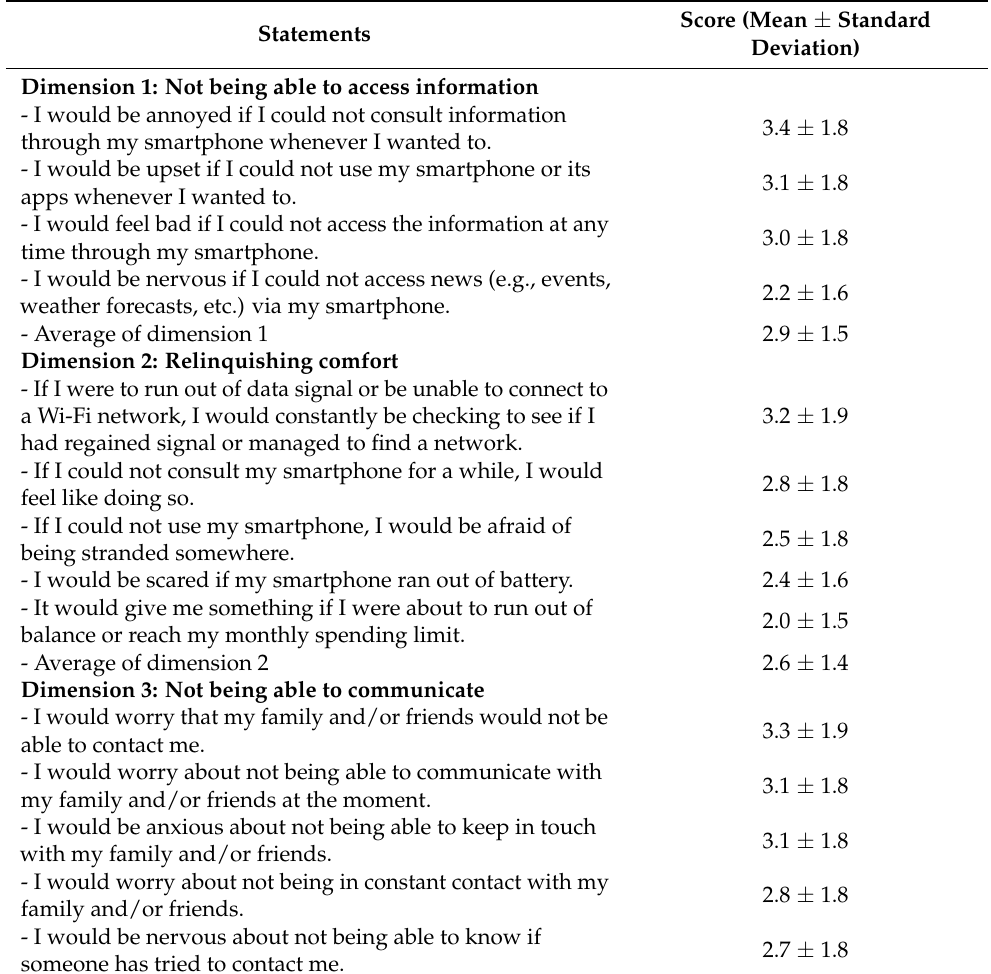
Table 2. Scores on each item and dimension of the NMP-Q (n =